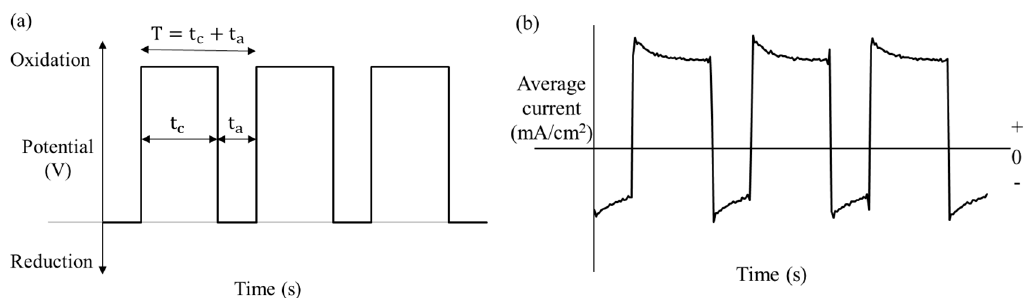
Figure 1. ( a ) Schematic representation of the pulse waveform for electrodeposition at duty cycle ( ϕ ) = t c /t c + t a = 67% (T: cycle time, t c :cathodic (forward) time, t a : anodic ( reverse) time) ( b ) Current density as a function of time during the pulsed electrodeposition.